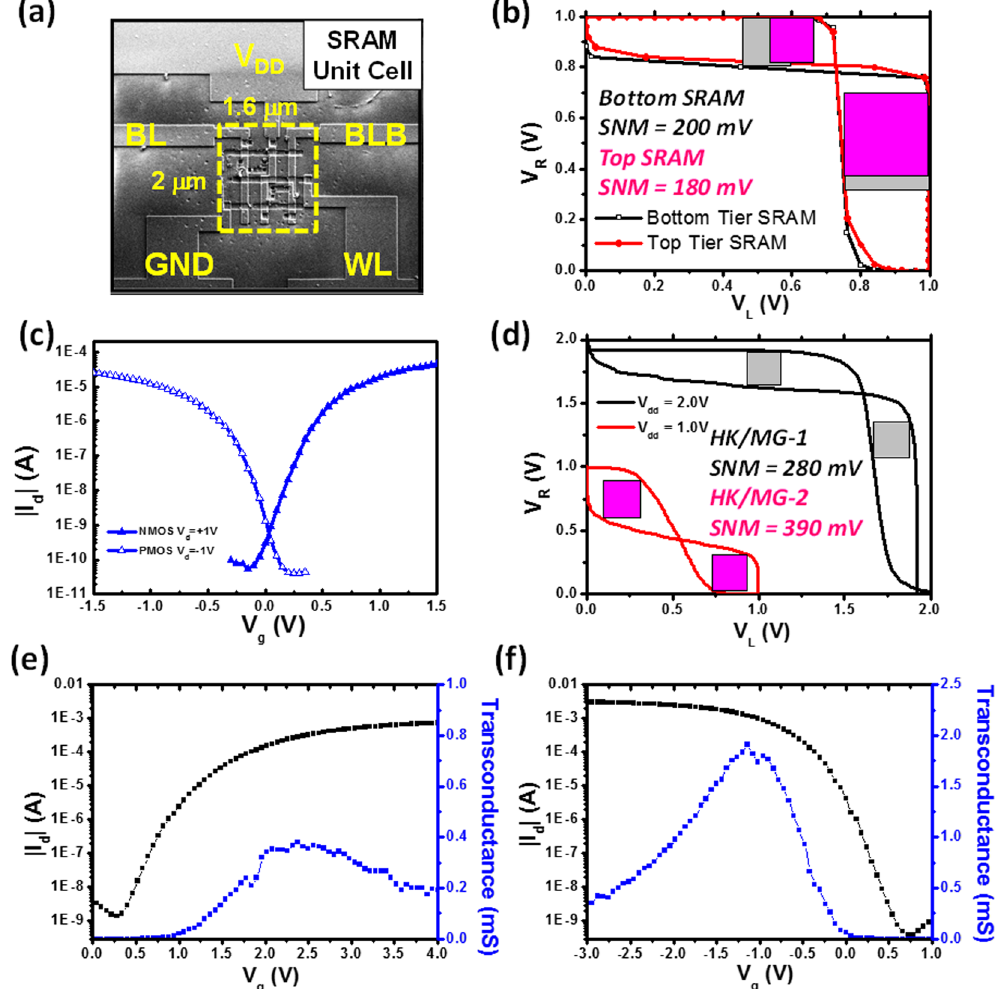
Figure 5. ( a ) A photograph of the compact 6T-SRAM circuit with a footprint of 2.0 × 1.6 µ m 2 . ( b ) A butterfly curve of bottom tier SRAM circuit and top tier SRAM circuit, which is used to determine SNM. ( c ) The improved transfer characteristics of threshold-voltage-optimized gate structures by HfO 2 gate dielectrics and TaN metal gate deposition. ( d ) An improved butterfly curve threshold-voltage-optimized gate structures, yielding a larger SNM. ( e and f ) Transfer characteristics and transconductance performance of multi-channel NMOSFETs and PMOSFETs for TFTs, analog or RF circuits